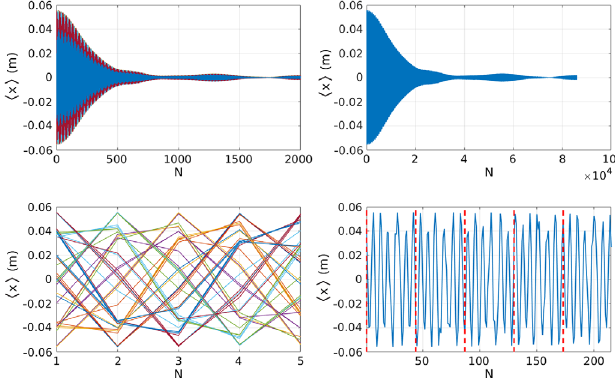
FIG. 2. Synthesis of a one-dimensional signal of 84 000 samples (top right), from an initial two-dimensional signal of N ¼ 2000 and M ¼ 42 (top left). The first turn from five BPMs are shown (bottom left). The signals from each BPM are represented with different colors. The transformation of the five turns results in 210 samples (bottom right) which increases the sampling rate. Each period is now populated by 42 samples of the original signal, and the periods are shown between the red dashed